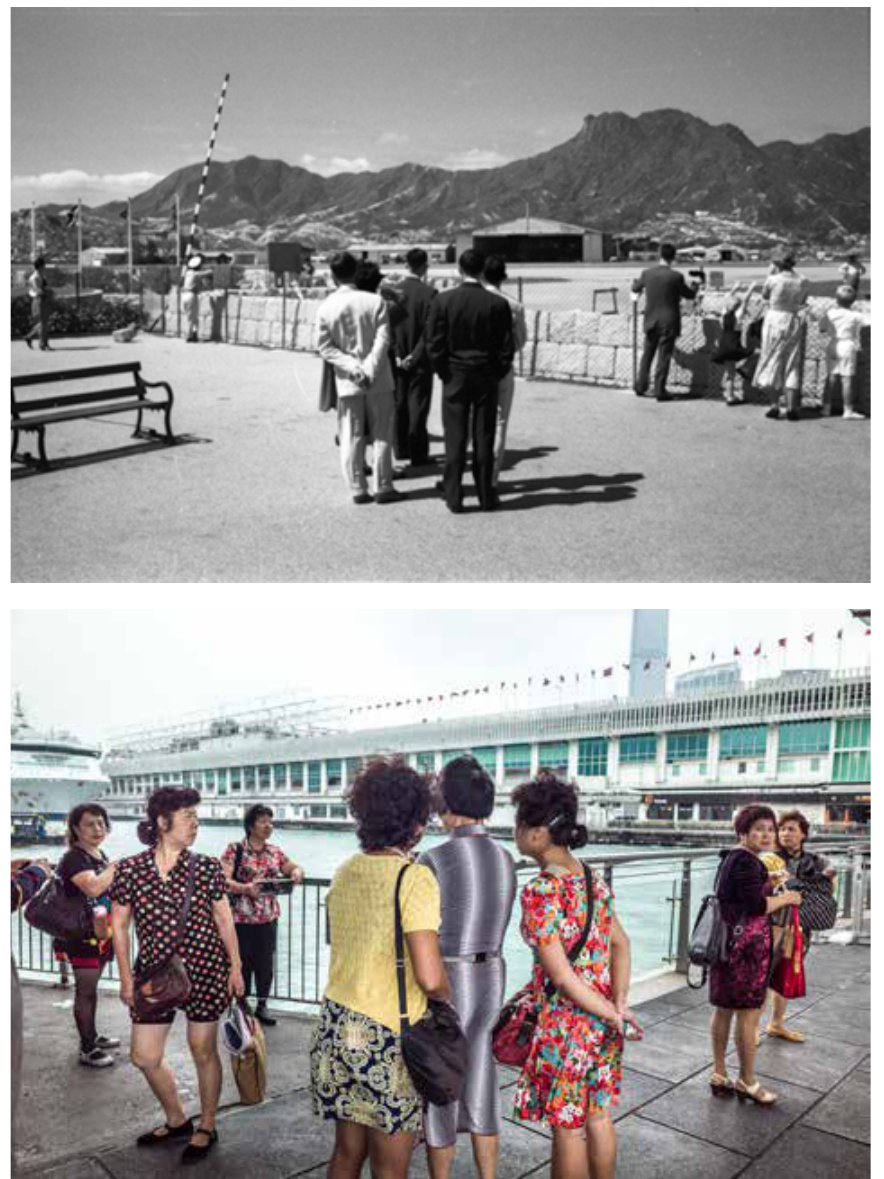
Figure 4a (top): Nick Howard, Men at Kowloon Dock, 1957/58. Figure 4b (bottom): Phil Shek, Women at Star Ferry Pier, Tsim Sha Tsui, Kowloon,